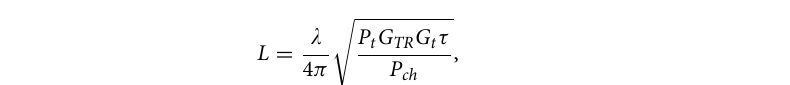
Figure 2. ( a ) Ceramic tag scheme. ( b ) Numerical assessment of the ceramic tags reading distance as a function of the cylinder’s permittivity. The operational frequency is constant f 0 = 867 MHz. The insets show the structures and their dimensions for two points on the graph. ( c ) Numerical |S 11 | spectra of the ceramic tag in free space for several ring’s positions (indicated in